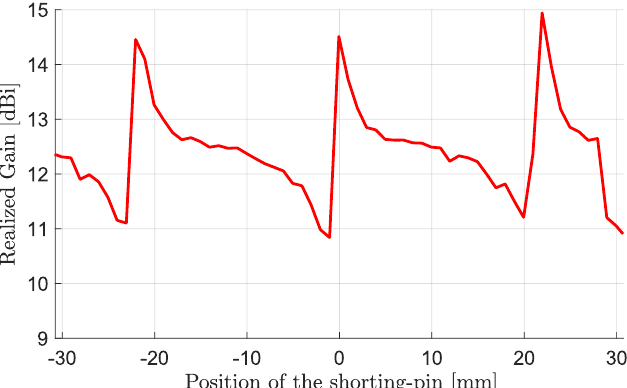
Figure 8. Gain of four-element antenna vs. position of shorting pin along feed patch.